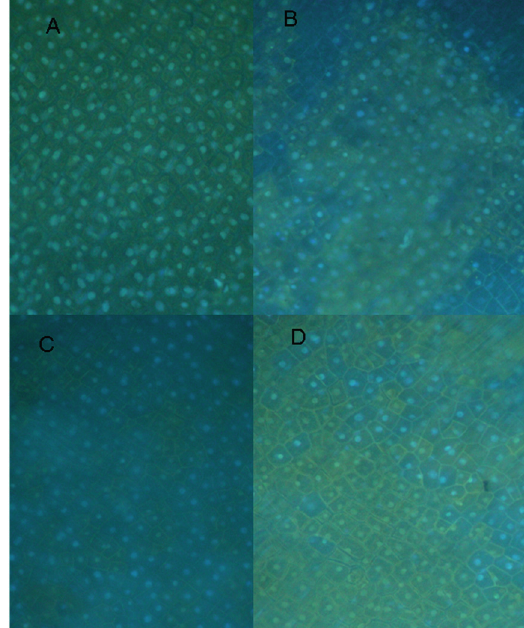
Figure 6. Effect of EDTA on the condition of nuclei within pea endocarp tissue.